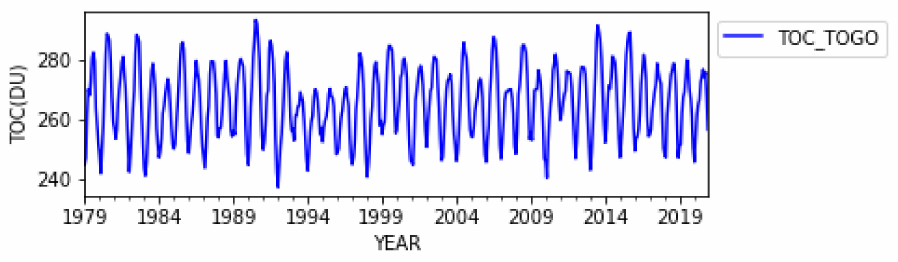
Figure 1. The monthly total ozone column over Togo from